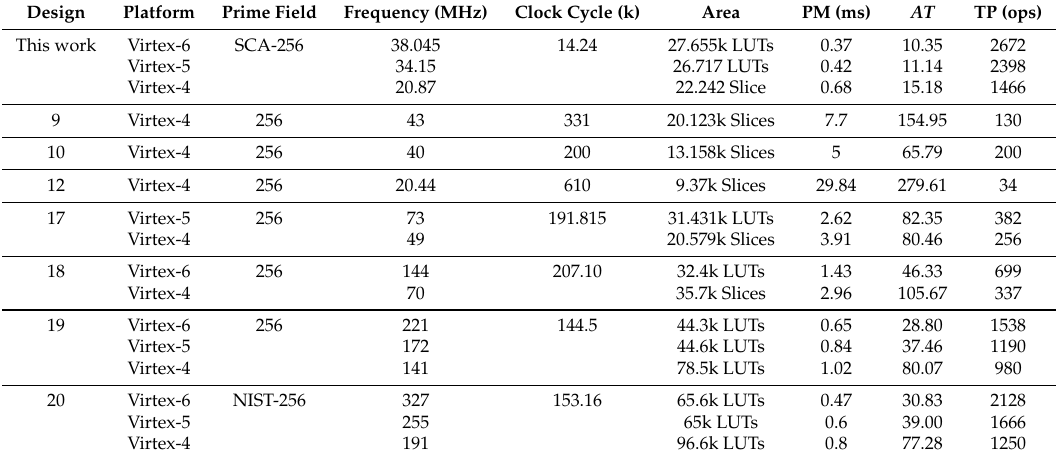
Table 5. ECC hardware performance comparison on FPGA platform.